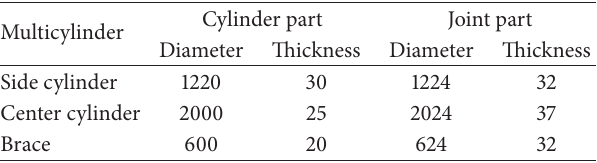
Table 2: Dimensions of multicylinder (mm).